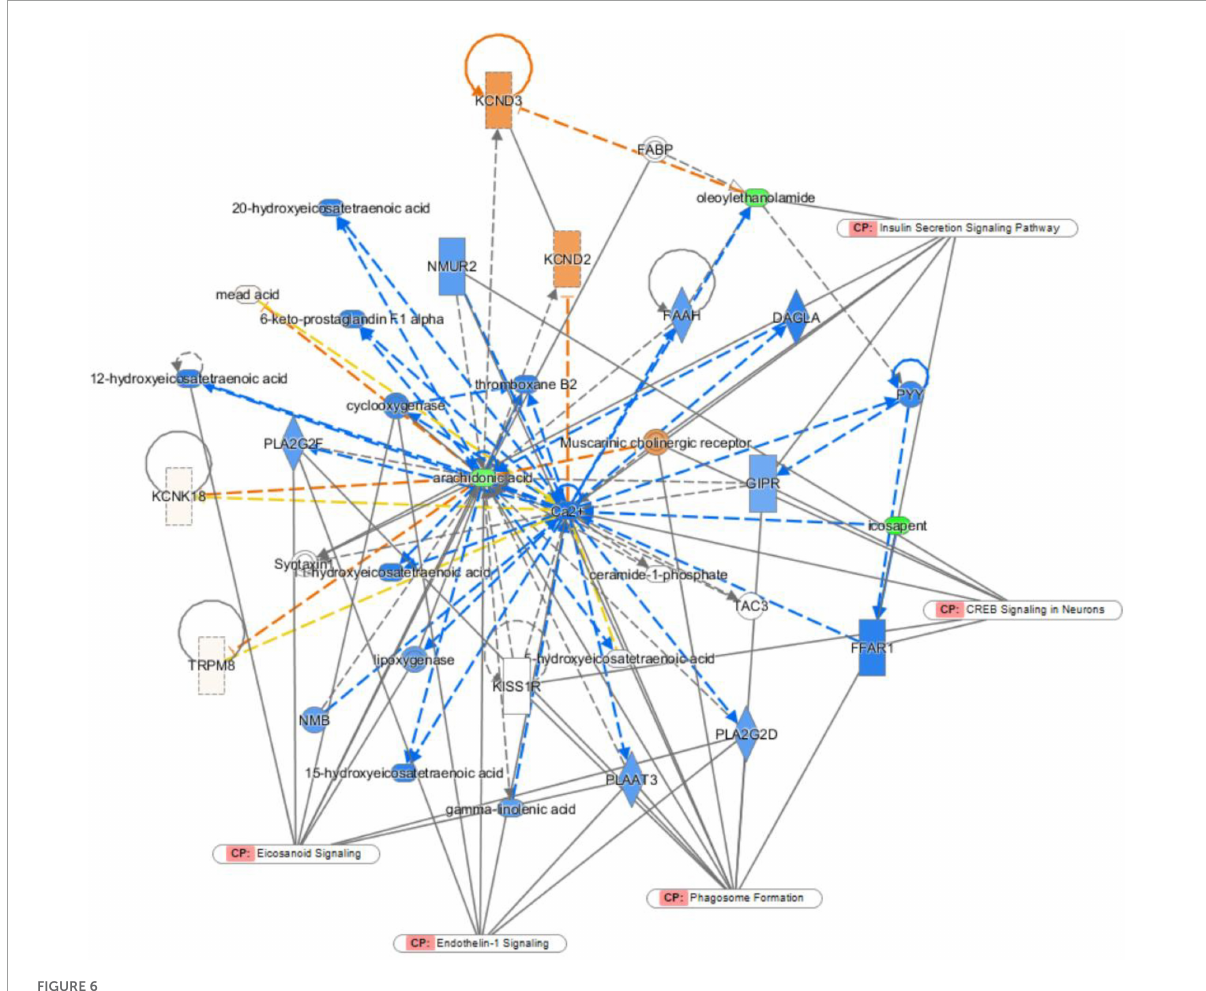
FIGURE6 Ingenuity pathway analysis (IPA)